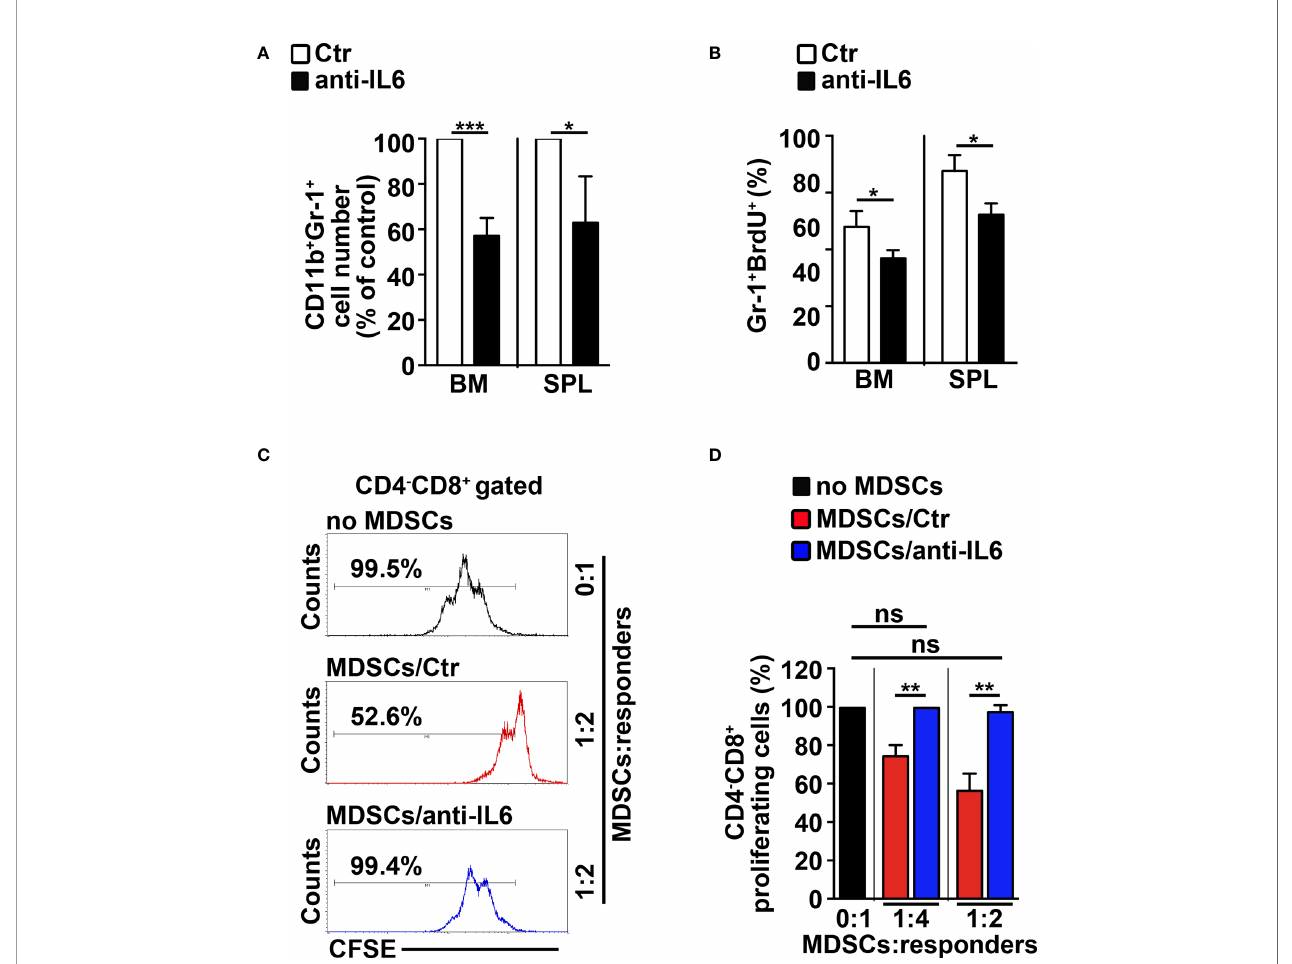
FIGURE 5 | IL-6 neutralization impairs MDSCs in N3-tg mice. N3-tg mice were injected i.p. with neutralizing anti-IL-6 antibodies (anti-IL-6) or isotype controls (Ctr), twice a week and sacri fi ced/analyzed after 4 weeks of treatment; some of the mice were also injected i.p. with BrdU solution 1 day before the sacri fi ce. (A) The graph reports the ratio between the CD11b + Gr-1 + cell counts in anti-IL-6-treated N3-tg mice and in control mice, expressed as % of control, measured by FACS analysis in the BM and spleen (SPL) and presented as mean value ± SD from three independent experiments ( n = 4 mice per group). (B) The percentages of Gr- 1 + BrdU1 + cells in the BM and SPL of anti-IL-6-treated N3-tg mice vs. controls are shown, assessed by FACS analysis. The data are presented as the mean value ± SD from two independent experiments ( n = 3 mice per group). (C) Representative FACS analysis of suppression assay of CFSE-labeled/activated wt T splenocytes ( “ responders ” ), cultured either alone (no MDSC), as a control, or in combination with Gr-1 + MDSCs ( “ suppressors ” ), at the indicated MDSCs/responders ratio. Numbers inside cytograms indicate the percentages of proliferating wt CD4 − CD8 + T responder cells. The Gr-1 + MDSCs were magnetically selected from spleen of N3-tg mice, treated with isotype control antibodies (MDSCs/Ctr) or anti-IL-6-neutralizing antibodies (MDSCs/anti-IL-6). In (D) , the results of the same suppression test, as in (C) , are illustrated as the percentage of proliferating CD4 − CD8 + responder cells in MDSC-containing cultures (MDSCs/Ctr or MDSCs/anti-IL-6) and in control cultures set up in the absence of MDSCs (no MDSCs), at the indicated MDSCs:responders ratio. The results represent mean values ± SD from two independent experiments ( n = 3 mice per group), with two technical replicates per experiment. ns, not signi fi cant, p > 0.05; * p ≤ 0.05; ** p ≤ 0.01, *** p ≤ 0.001 represent signi fi cant differences between the indicated